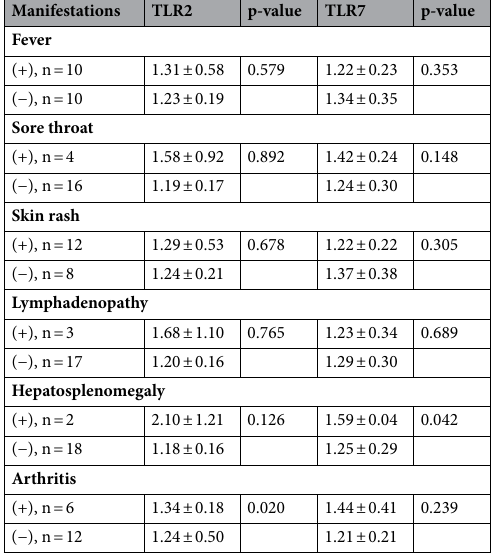
Table 3. Comparison of the intensities of Toll-like receptor2 (TLR2) and TLR7 expression according to disease manifestations in adult onset Still’s disease. These data were assessed using a Mann–Whitney U test.